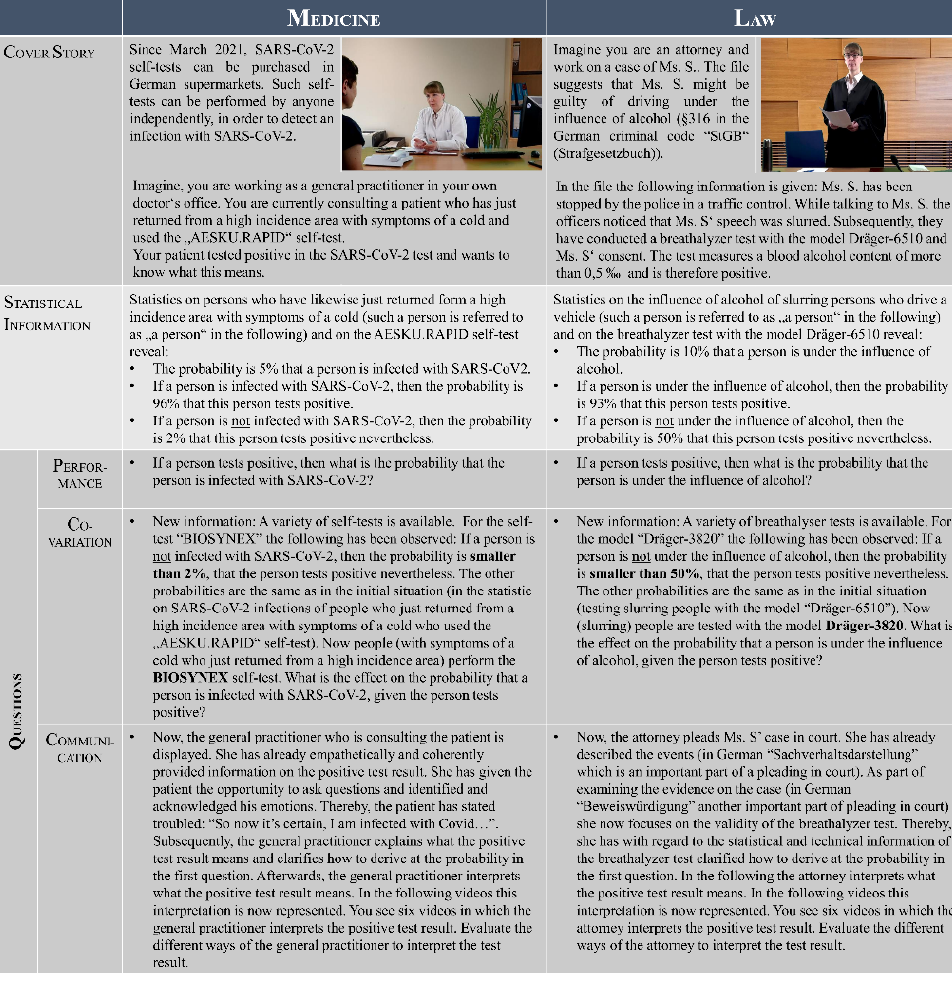
Figure 2. Examples of l earning tasks for medicine and law, respectively.